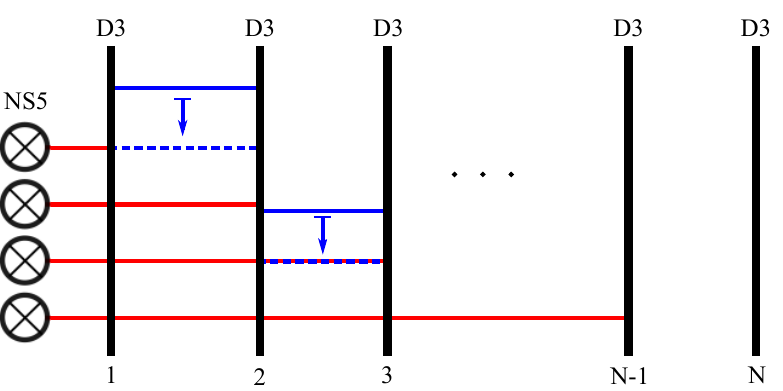
Figure 9 . This (cid:12)gure describes a Hanany-Witten dual frame of the brane con(cid:12)guration in which monopole bubbling appears to be a singular process. In this (cid:12)gure we can see that bubbling of the (cid:12)nite D1-branes (blue) occur when they become spatially coincident with the NS5-brane (and associated D1-branes in red) in the x 1 ; 2 ; 3 -directions. Here, one can see that in this frame, bubbling is non-singular as it corresponds to at most coincident